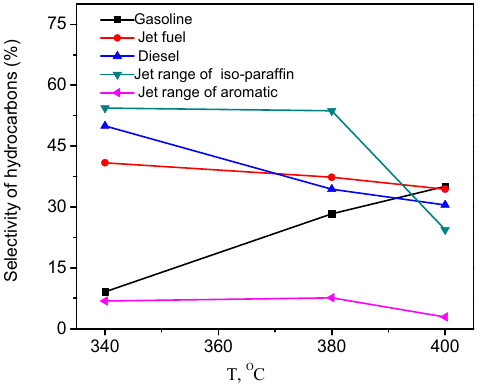
Figure 6. Selectivity for the formation of hydrocarbons using NiMo/SBUY-MCM-41 at different reaction temperatures. Reaction conditions: 3 MPa and 500 mL/mL.